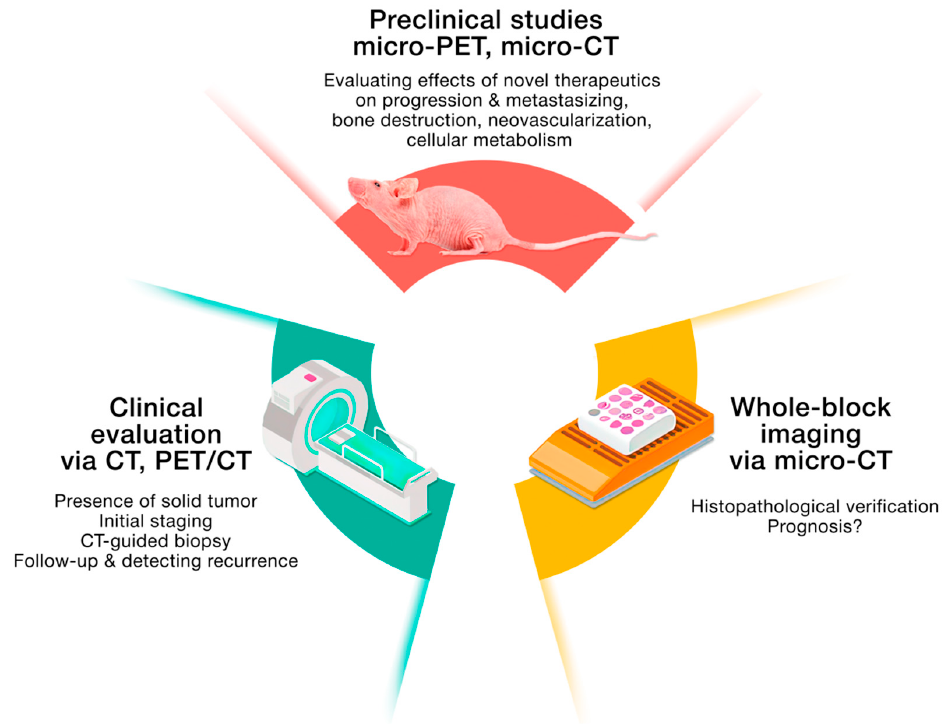
Figure 1. Current imaging techniques and their objectives in sarcoma diagnostics and preclinical